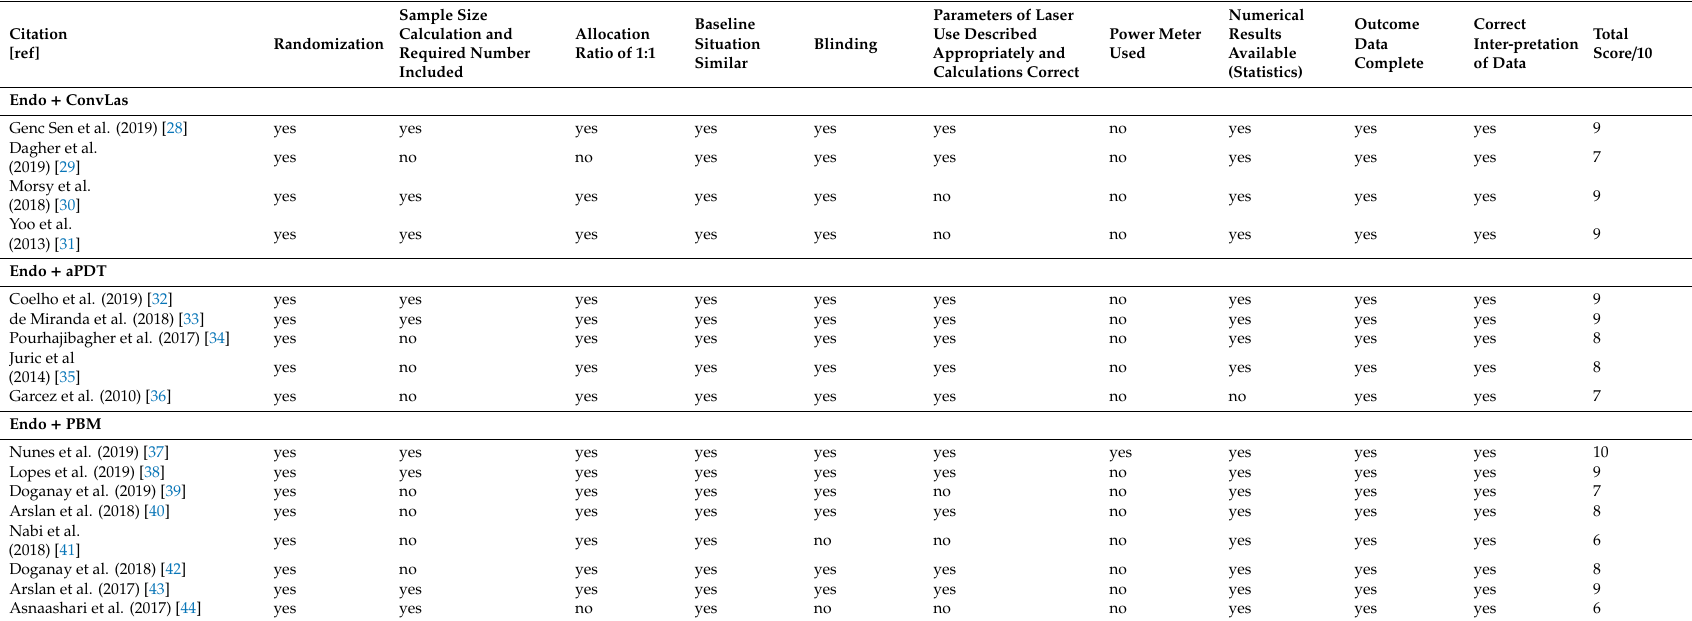
Table 4. Risk of bias